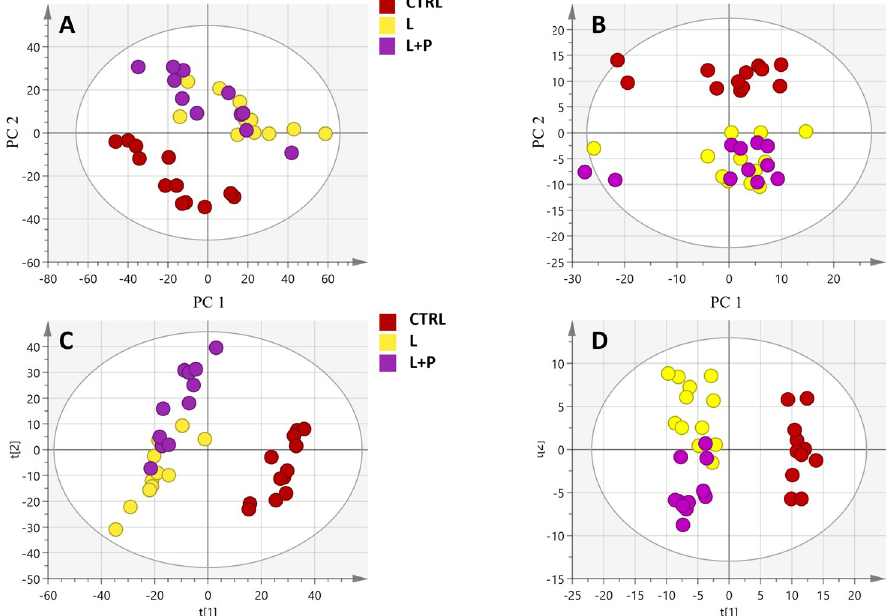
Fig 1. Unsupervised principal components analysis (PCA) models built using raw data from positive (A; R 2 cum = 0.39) and negative (B; R 2 cum = 0.59) ionization modes. The diet groups i.e., control (CTRL), linseeds